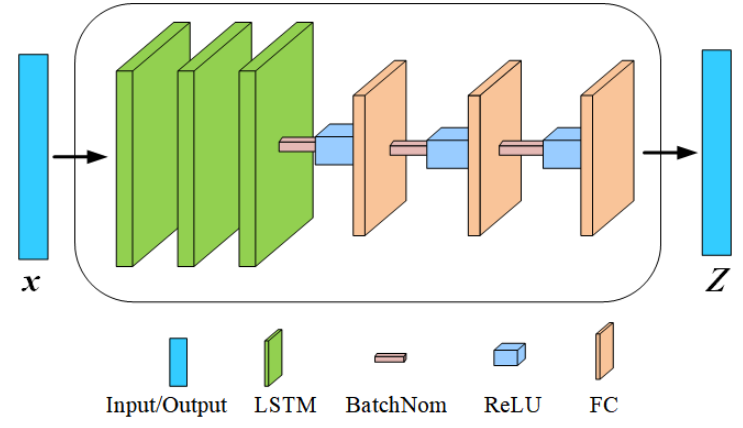
Figure 5. Network structure of encoder.